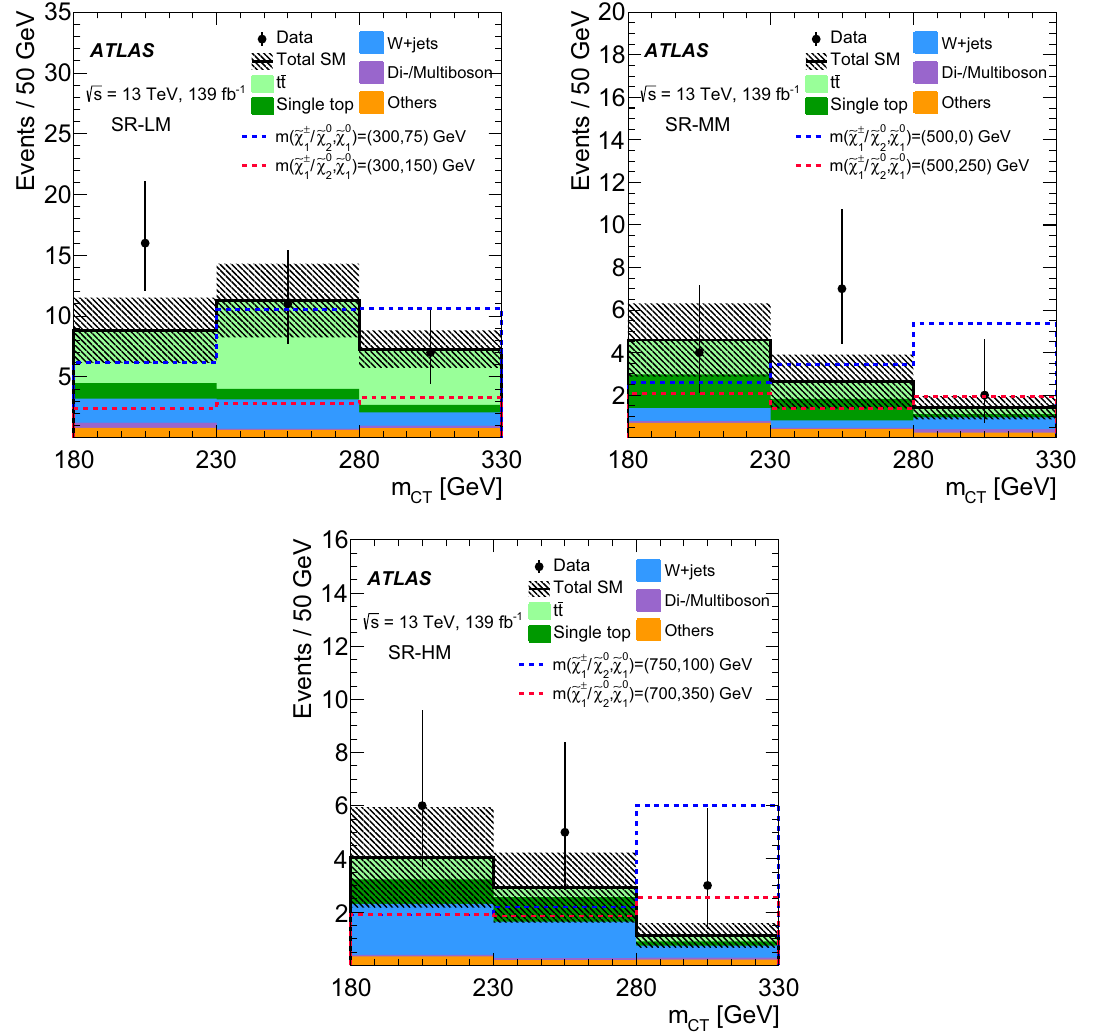
Fig. 5 The post-fit m CT distributions in the exclusion signal regions (SR-LM, SR-MM, and SR-HM). The uncertainty bands plotted include all statistical and systematic uncertainties. The dashed lines represent the benchmark signal samples. The overflow events, where present, are included in the last